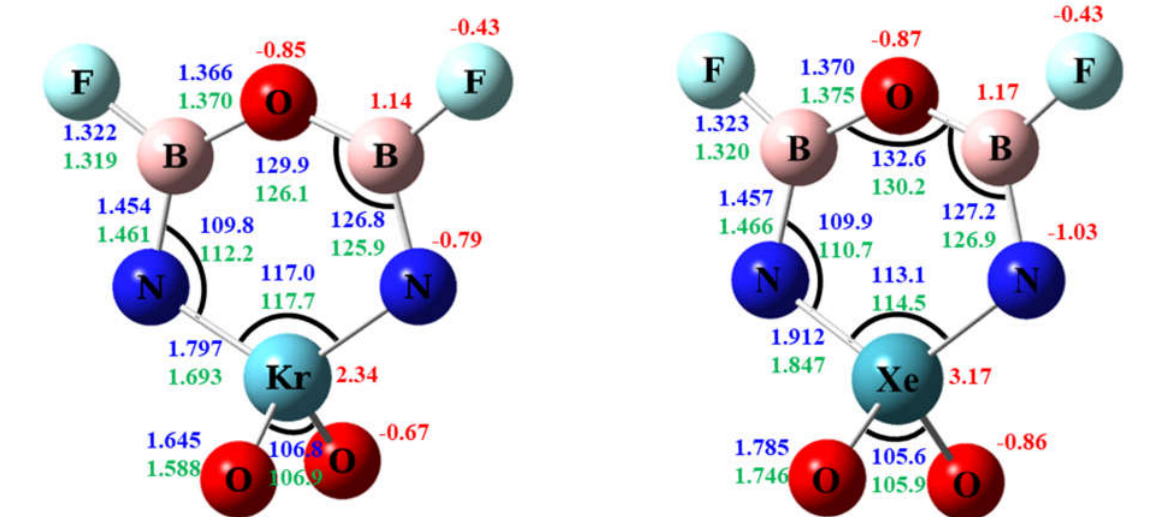
Figure 1. Calculated structure of NgO 3 N 2 B 2 F 2 (Ng = Kr, Xe). The bond distances are in angstroms and the bond angles in degrees. The numbers in blue and green are values calculated by the B3LYP/aptz and MP2/aptz methods, respectively. The values in red are NBO atomic charges at B3LYP/aptz level.